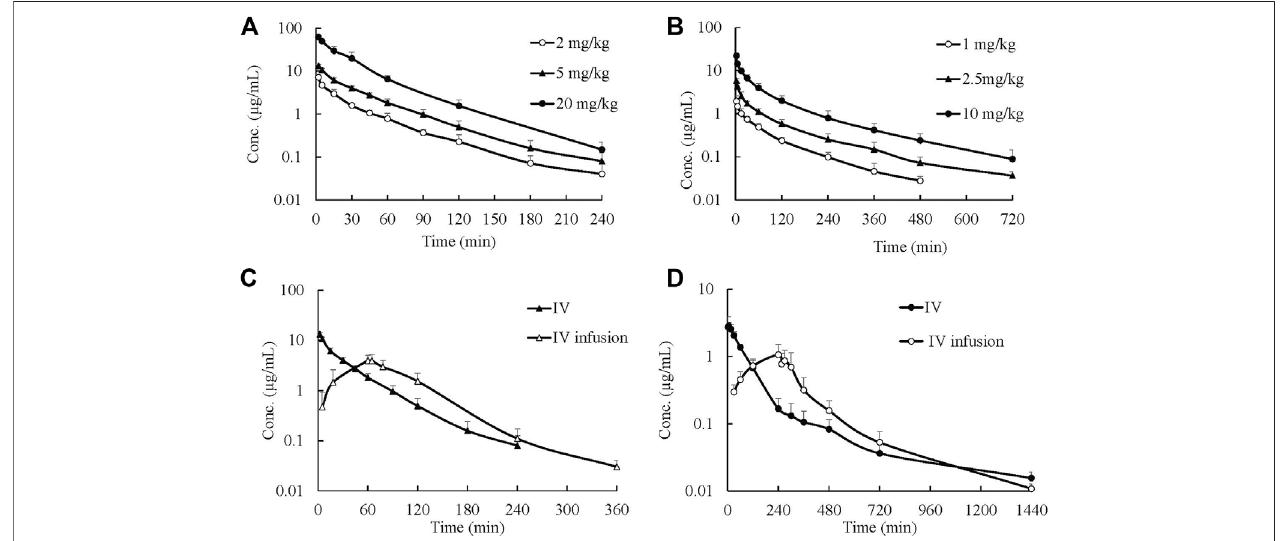
FIGURE2 | Plasma ST-246 concentrationversustimecurves in rats, dogs, and monkeys after intravenous bolus (IV) at different dosagesand intravenous infusion administration inratsand monkeys( n =6,mean ±SD). (A) PKcurves ofST-246 via IV inrats; (B) PK curves ofST-246 via IV inbeagle dogs; (C) PK curves ofST-246 via IV and 1 h IV infusion at a dose of 5 mg/kg in rats; (D) PK curves of ST-246 via IV and 4 h IV infusion at a dose of 3 mg/kg in monkeys.